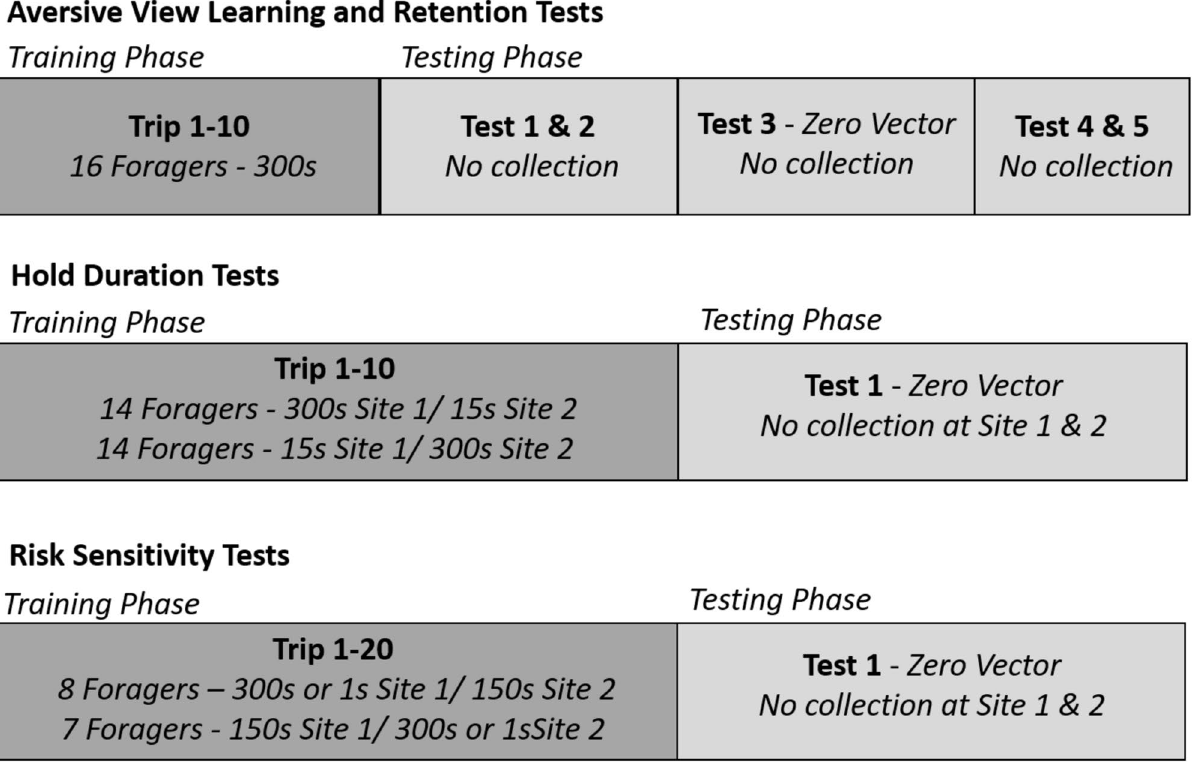
Figure 2. Timeline of training and testing procedures in all